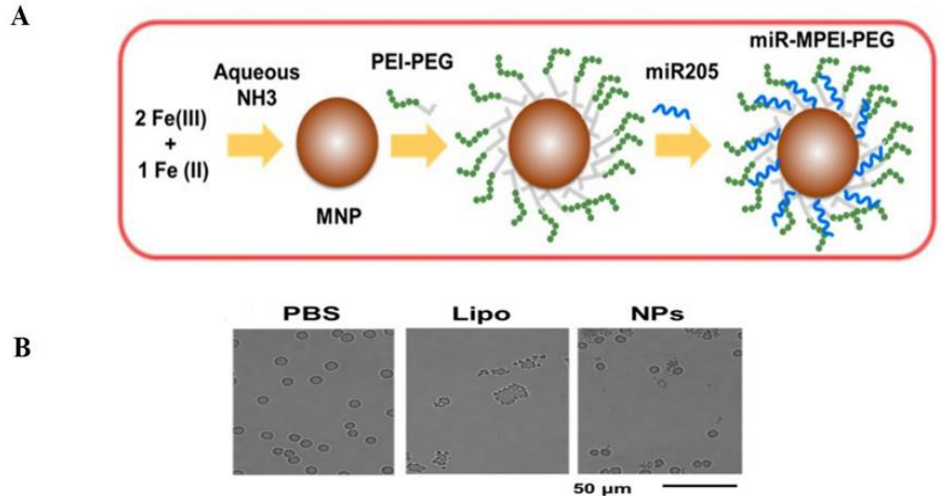
Figure 4. ( A ) Preparation of miR-205 loaded MNP nanoformulation. ( B ) Hemolysis images of miR- 205 MNP nanoformulation. Microscopic images showing hemolytic characteristic of human red blood cells. This figure was adopted from our previous publication [215].